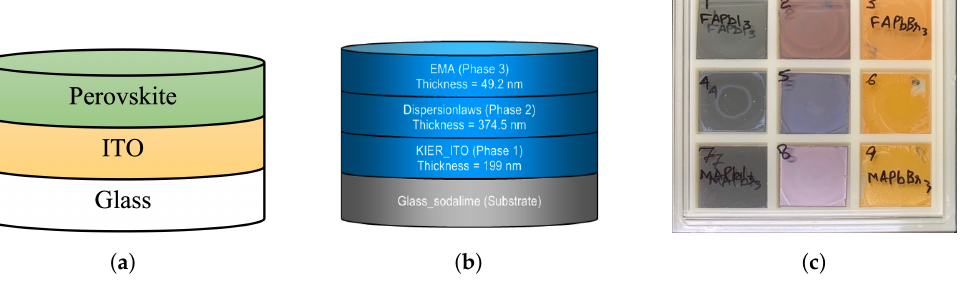
Figure 1. Perovskite material specimen defined by quaternary stoichiometric ratio; ( a ) thin-film laminated structure of specimen; ( b ) optical model structure for ellipsometry; ( c ) Perovskite samples.